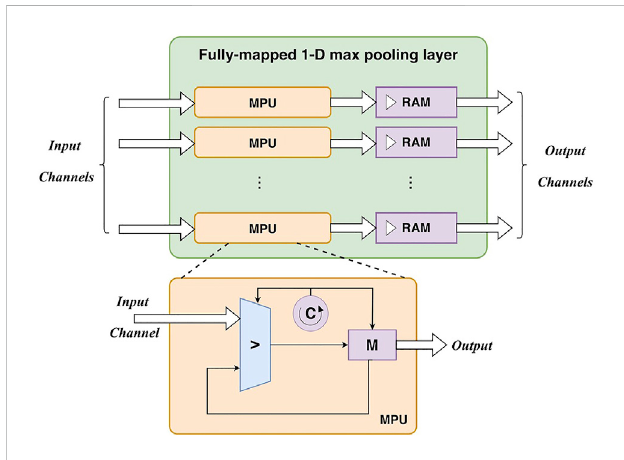
FIGURE 4 The hardware design of a fully-mapped 1-D max-pooling layer. MPU: max-pooling